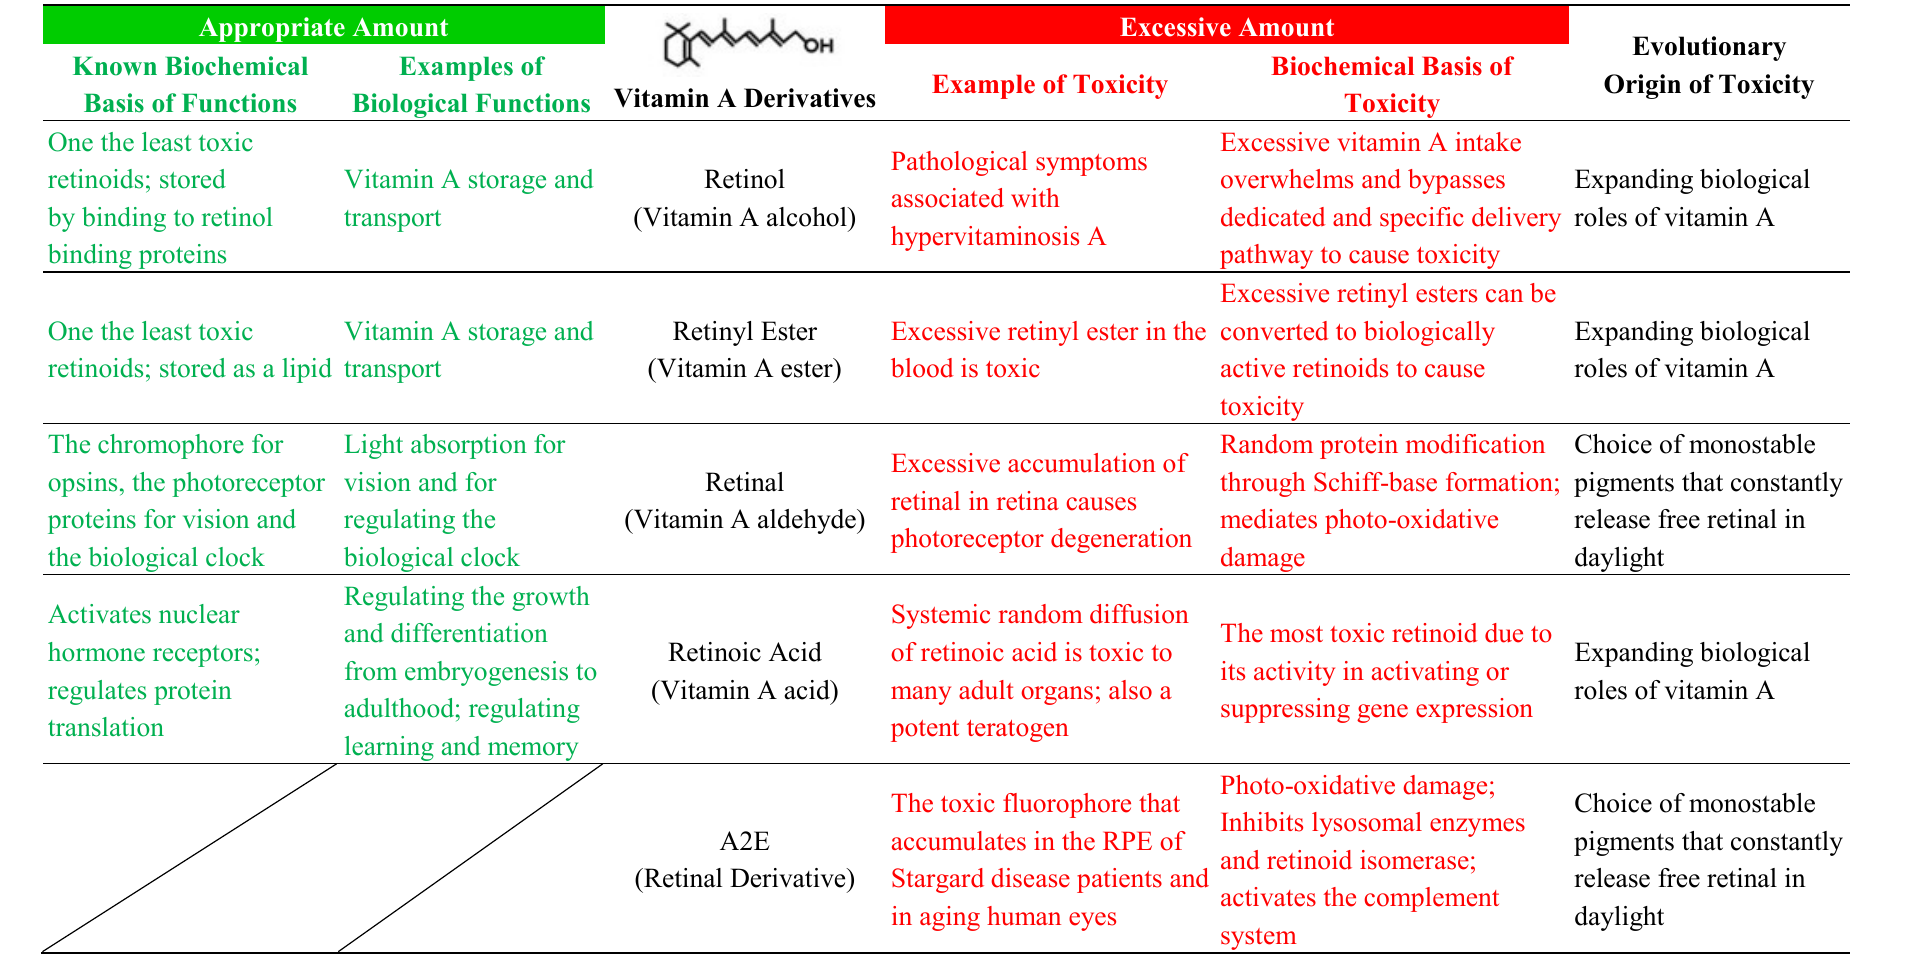
Table 4. Biological functions and toxicities of vitamin A derivatives in